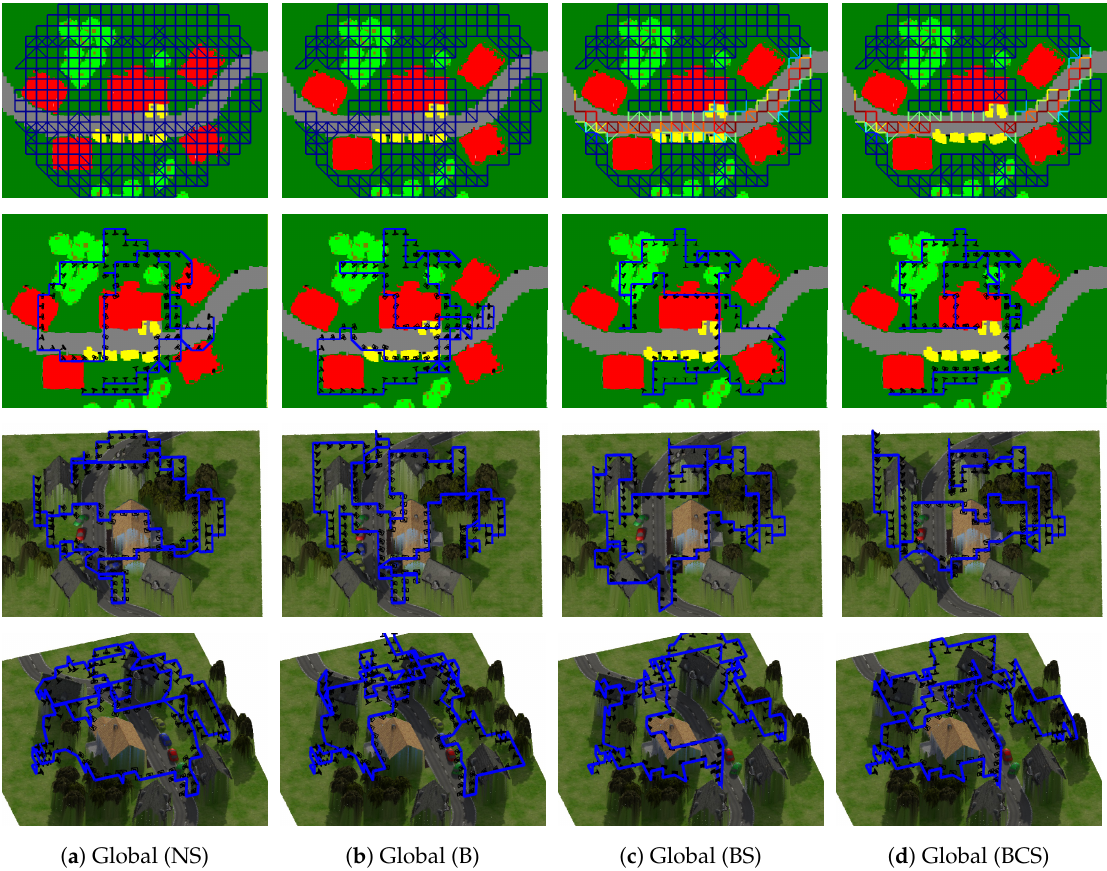
Figure 8. Visualization of the optimized paths for different semantical restrictions on the airspace for the synthetic scene. The first row shows a nadir view of the entire camera graph as accessible and traversable UAV viewpoints. Color-coded edges represent associated semantical costs w sem corresponding restrictions. The second row visualizes the optimized camera paths together with the acquisition viewpoints as black camera symbols. Different perspectives with the RGB proxy model are shown in the third and fourth row.